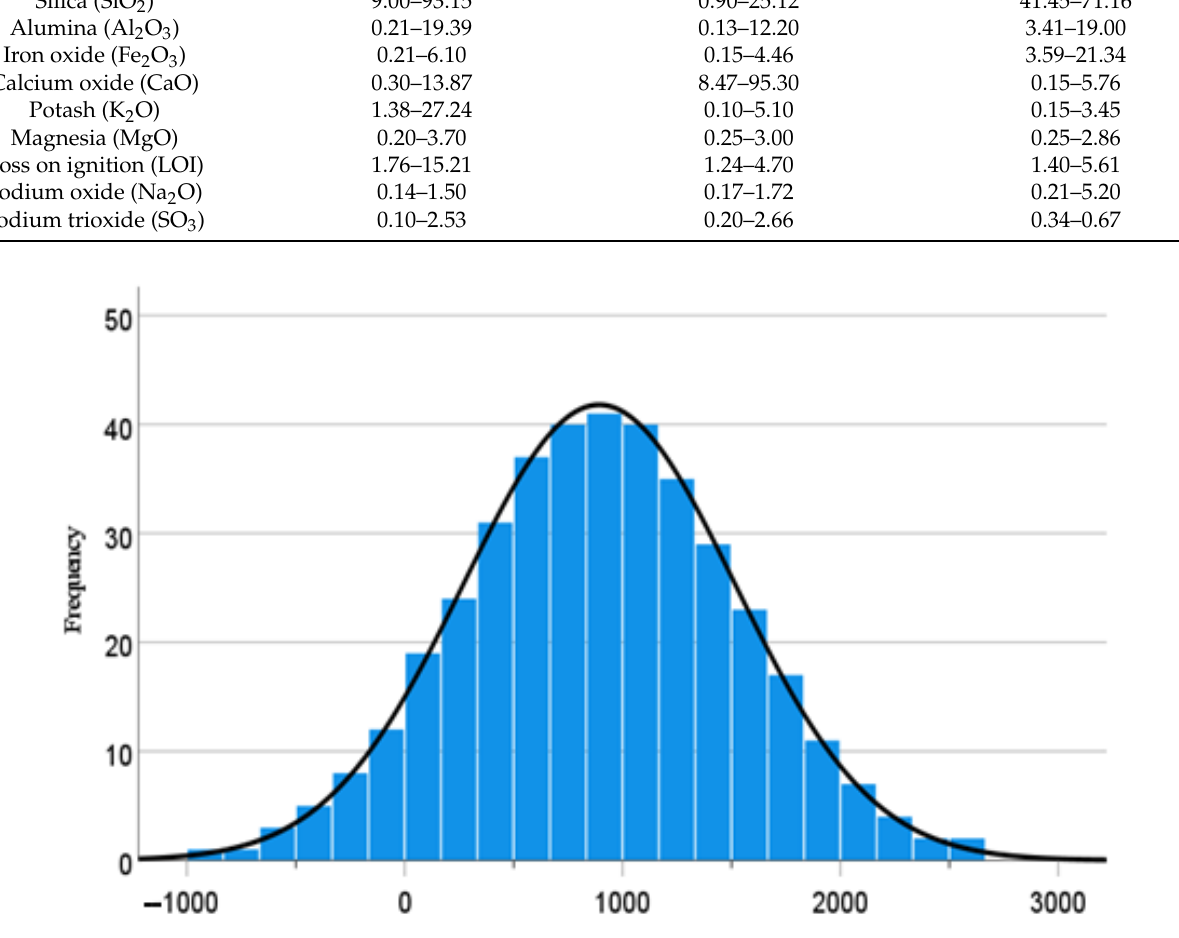
Figure 1. Normal distribution of values of UCS. Table 3. Statistical measures of input features and target